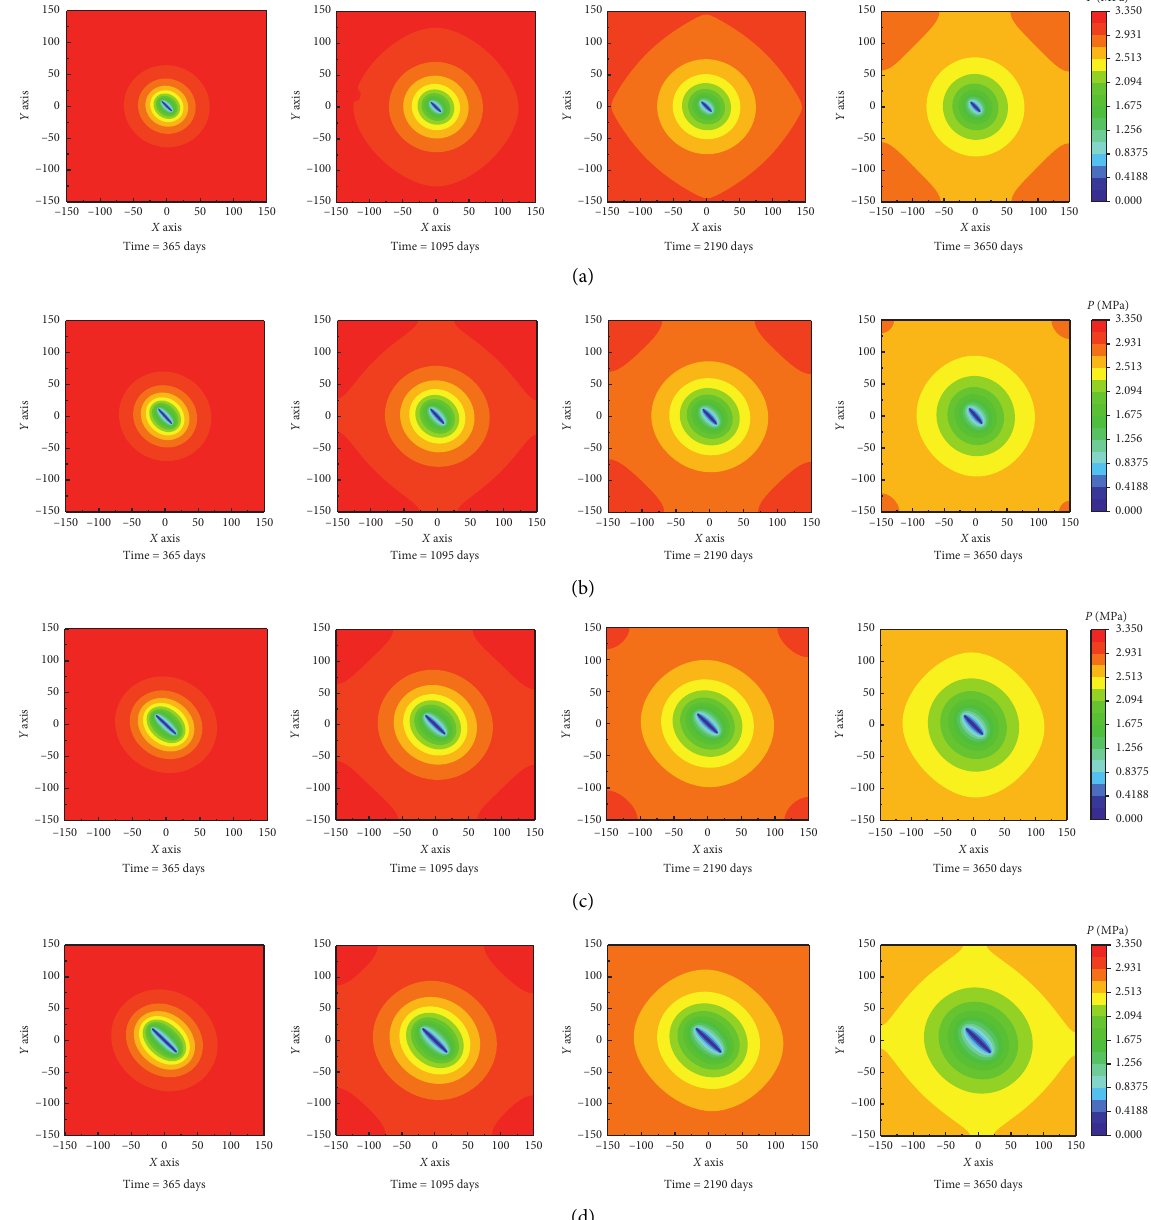
Figure 11: Variation of coalbed methane pressure with different fracture length. (a) L � 10m. (b) L � 15m. (c) L � 20m. (d) L �